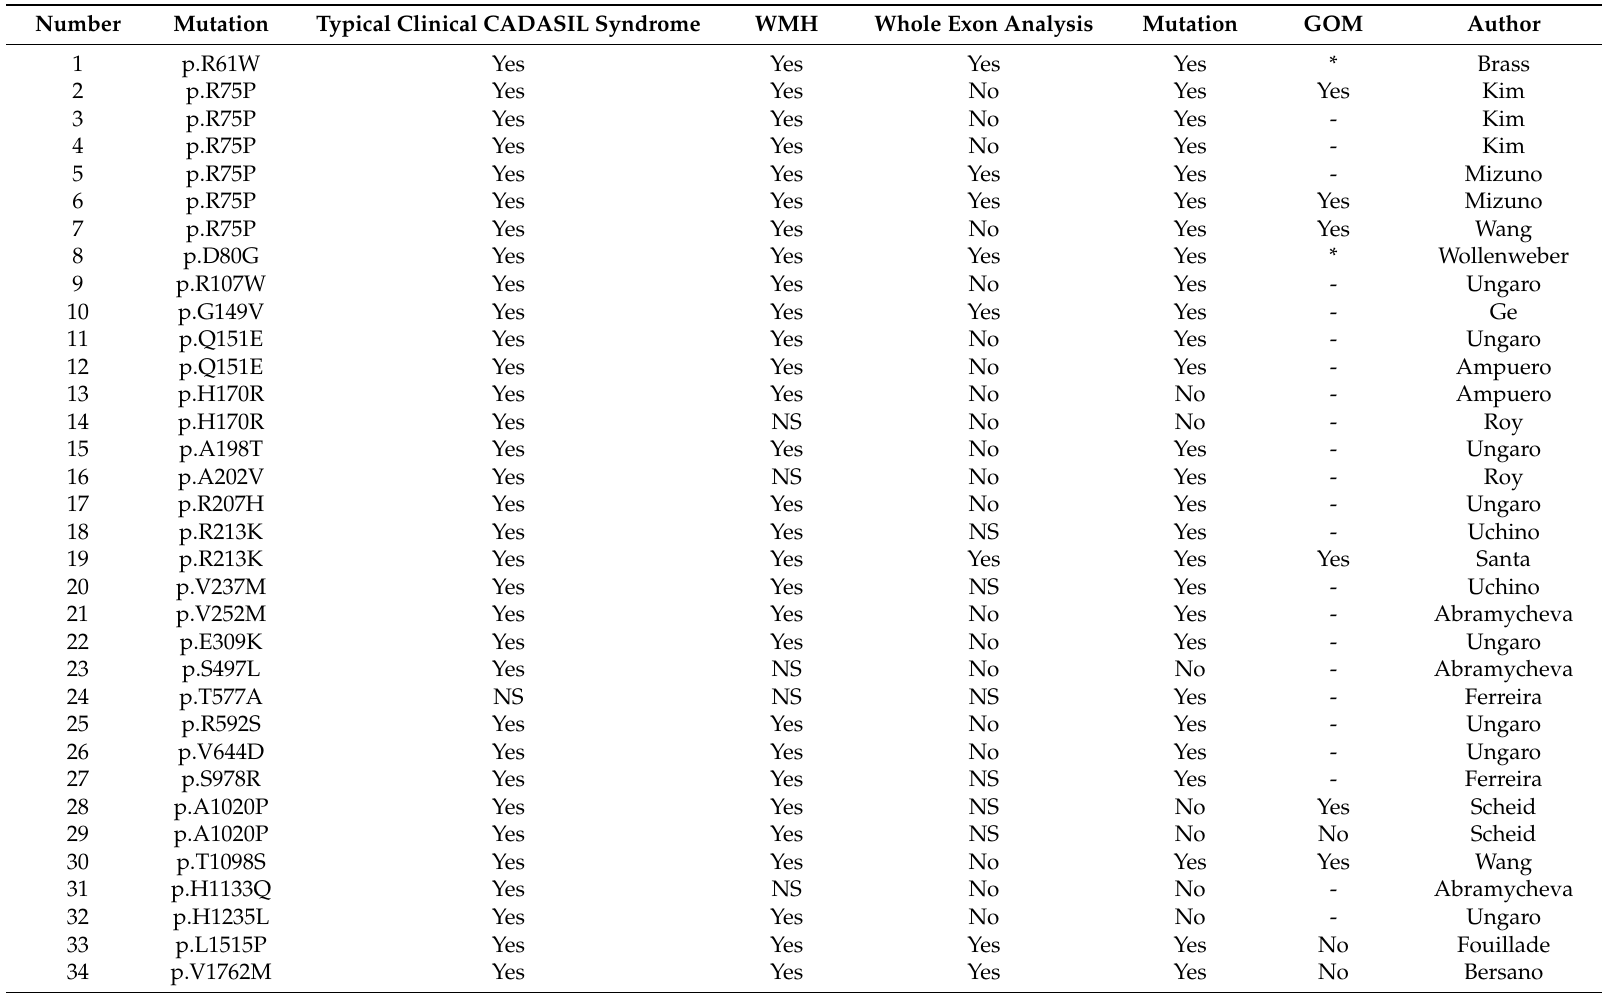
Table 3. Summary of the main characteristics of cysteine-sparing NOTCH3 missense